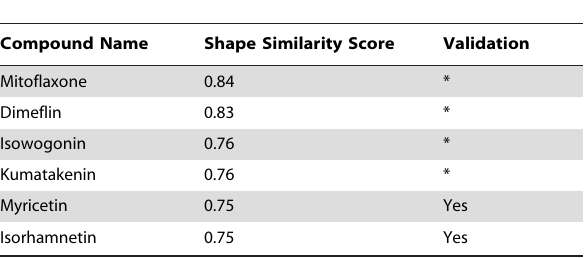
Table 3. Sixflavonoid candidate inhibitors for